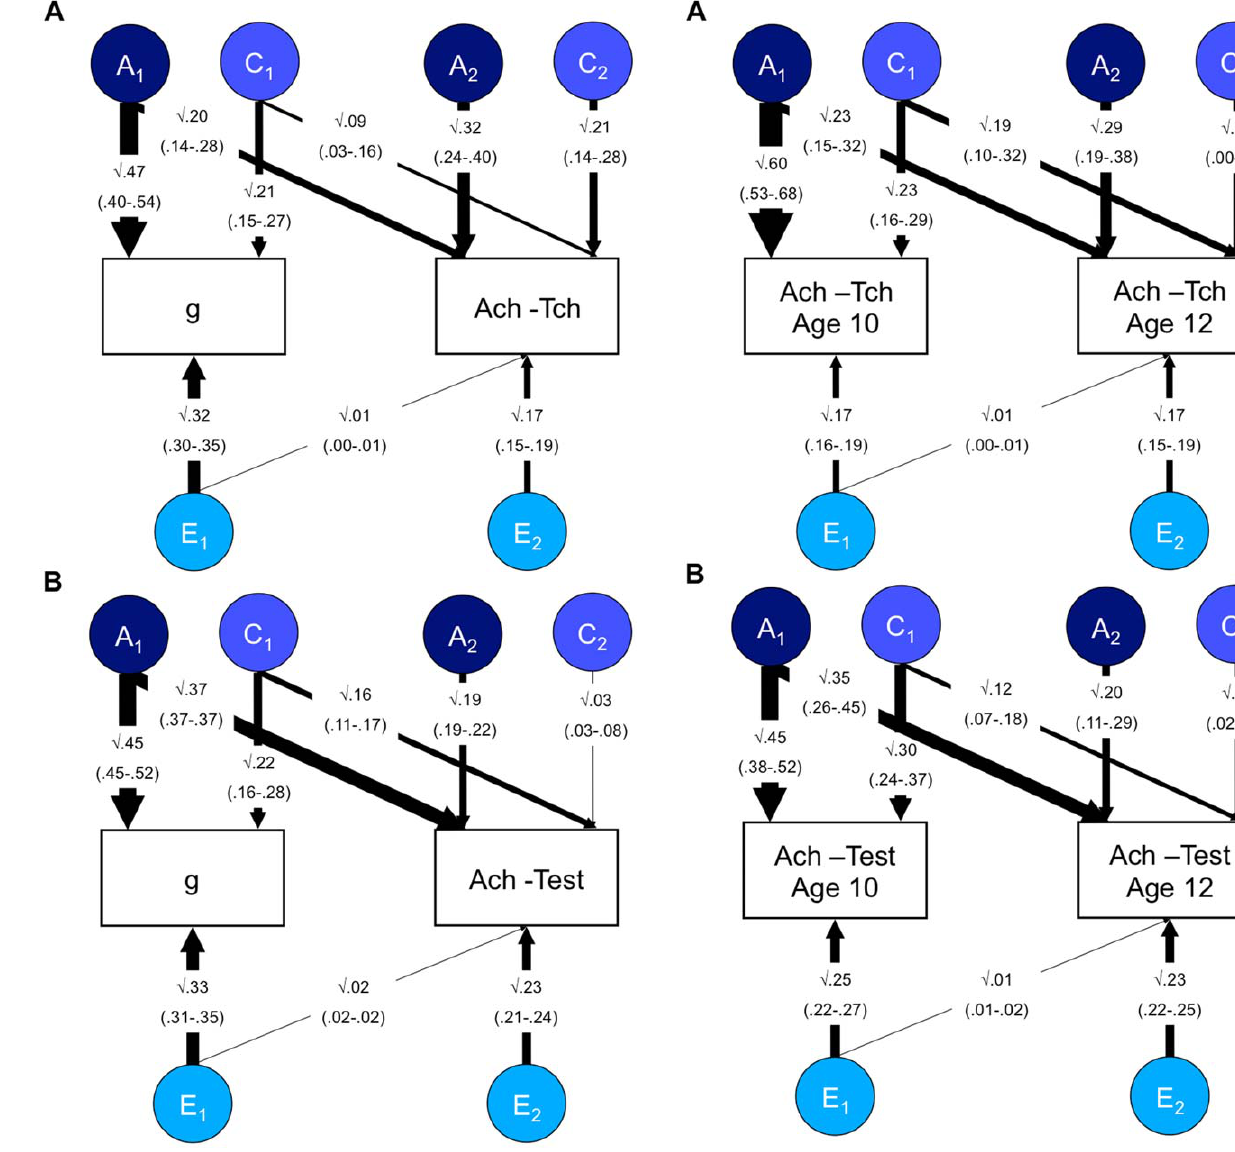
Figure 1. Bivariate analysis of g and achievement. Panel A=g and teacher-rated achievement at 12 years. Panel B=g and test achievement at 12 years. g= general cognitive ability; Ach-Tch = Teacher-rated achievement; Ach-Test = test achievement; A= additive genetic; C= Shared environment; E= Non-shared environment. The figures represent the results from a standardized Cholesky decompo- sition of twin data. 95% confidence intervals of the path estimates are shown in parentheses. The first factors assess genetic (A 1 ), shared (C 1 ) and non-shared environmental (E 1 ) influences on g , some of which may also influence school achievement. The second factor estimates influences on achievement that are independent of the influences on g (A 2 , C 2 and E 2 ). Results indicate significant residual genetic influence on school achievement, even when the genetic and environmental co- variance with general cognitive ability has been removed (see the A 2 path estimate).